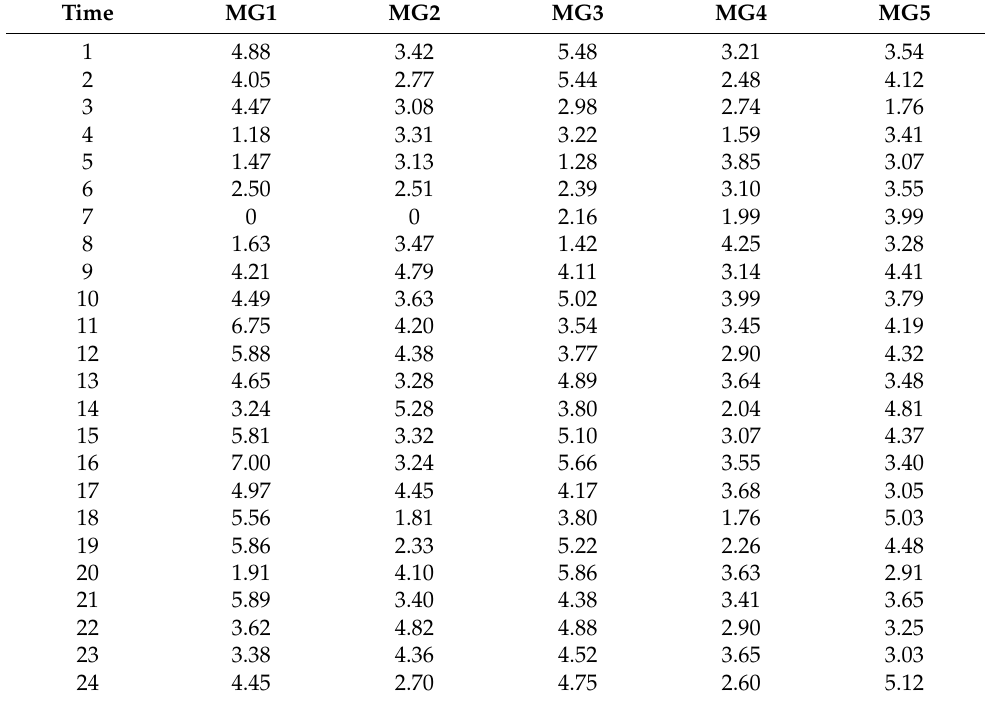
Table 10. Total power generated in MW for each MG using the ANN-BPSO schedule controller for 24